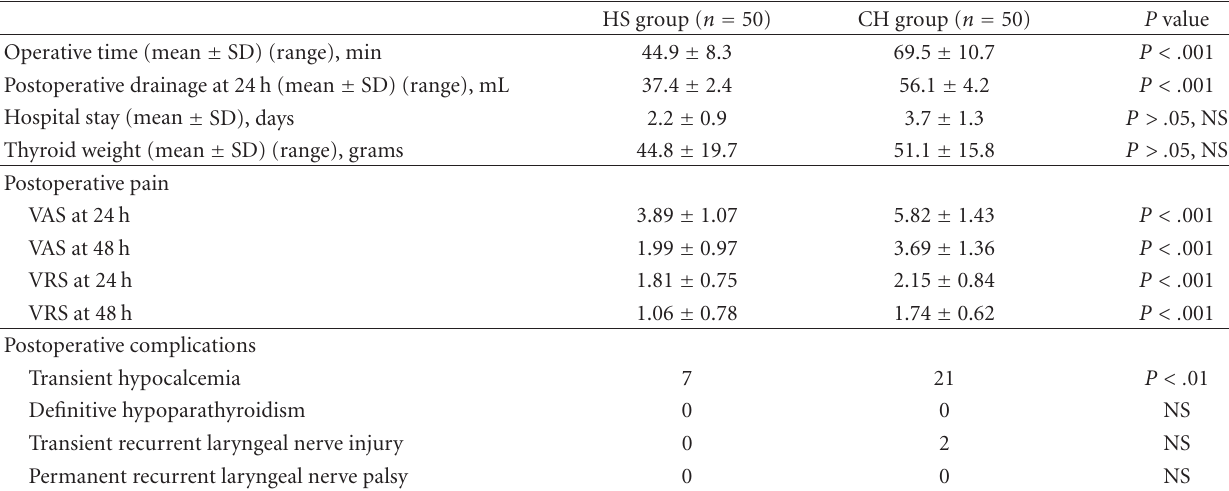
Table 2: Operative and postoperative data in HS (Harmonic Scalpel) and CH (Conventional Hemostasis) groups. HS group ( n = 50) Operative time (mean ± SD) (range), min Postoperative drainage at 24h (mean ± SD) (range),